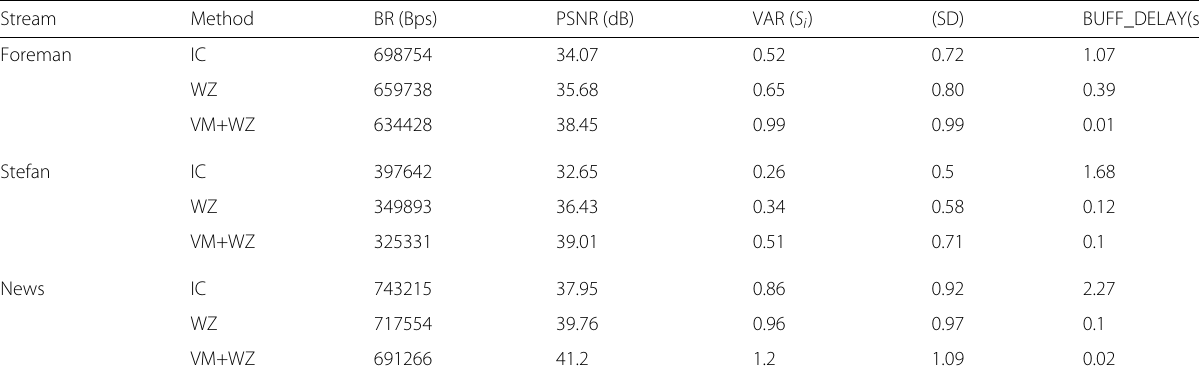
Table 1 Inference of different bit rate reduction and frame reconstruction techniques Stream